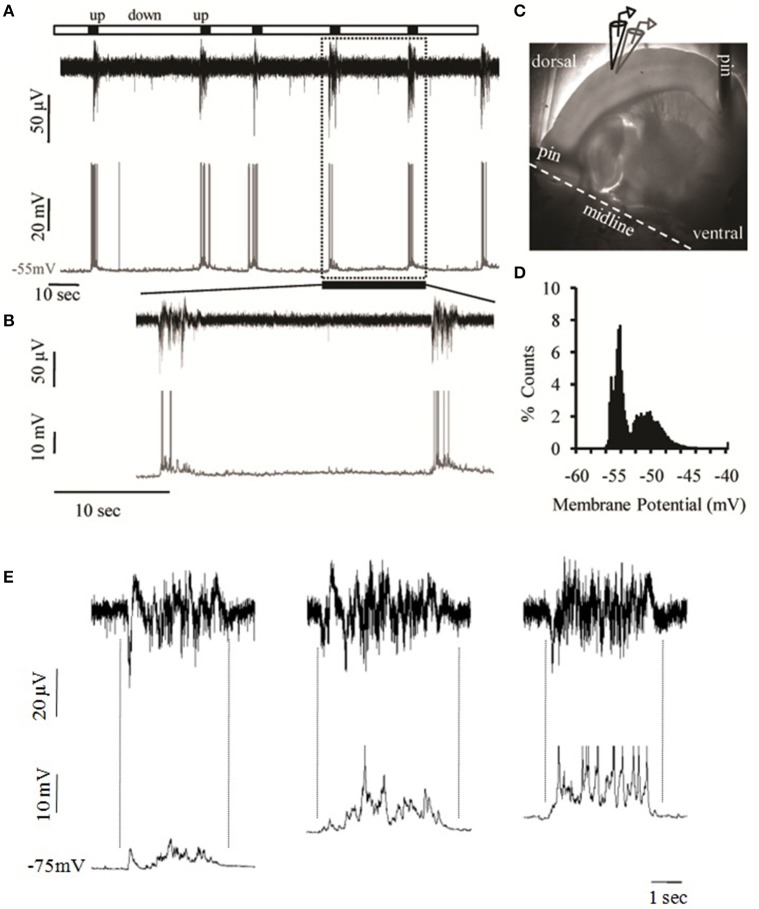
Spontaneous cortical Up states in vitro. (A) Simultaneous extracellular (field potential, black) and intracellular (whole cell patch clamp, gray) recordings of spontaneous network activity from layers 2/3 and 4, respectively, of an S1BF cortical slice of a 15 days old male mouse. (B) Detail of recording period shown in (A) as defined by the dotted box in order to zoom into two individual Up states. (C) The mouse brain slice pinned onto a transparent layer of silicone and the arrangement of extracellular (black) and intracellular (gray) recording electrodes in cortical layers 2/3 and 4, respectively. (D) Example of the bimodal voltage distribution of a neuron's intracellular recording. The histogram represents the time spent at each observed membrane potential. The calculation is based on the distribution of the membrane potential of the cell recorded in (A, lower trace) as sampled from 300 ms segments of six Up states and six equally large segments of the baseline (Down state). (E) Spontaneous Up states recorded simultaneously extracellularly (upper traces); and intracellularly (lower traces) in successively more depolarized membrane potentials (left trace: −75 mV, middle trace: −65 mV, right trace: −60 mV). Dotted lines indicate the alignment between LFP and intracellular traces. The degree of alignment was quantified by calculating the correlation coefficients (CC) between the LFP and Vm recordings, which is a measure of the extent to which two measurement variables vary together. While CC values for either the Up or the Down states were extremely low (CCDown = 0.03 ± 0.03, CCUp = 0.02± 0.13), CC values for the transition phases were significantly higher (CCDown−to−Up = −0.73±0.15, CCUp−to−Down = 0.57± 0.22, n = 5), indicating that LFP and Vm values co-vary in near synchrony.